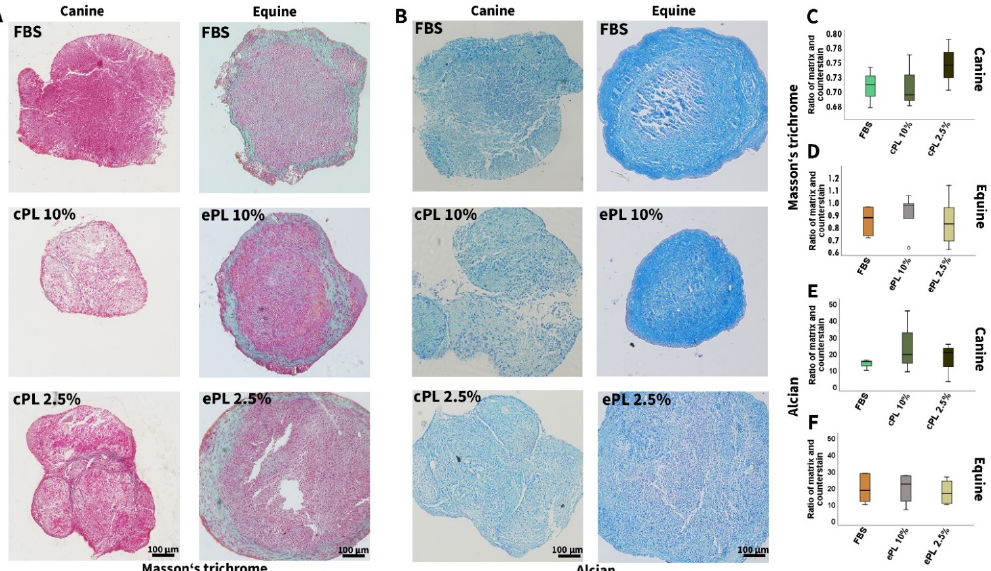
Figure 6. Chondrogenic differentiation. Representative bright-field photomicrographs show canine (left column) and equine (right column) mesenchymal stromal cells (MSC) after chondrogenic differentiation and Masson’s trichrome ( A ) and Alcian ( B ) staining. Boxplots display the corresponding data obtained by image analysis using Fiji ImageJ ( C – F ). MSC were cultured in the media indicated before differentiation was induced (FBS: fetal bovine serum; cPL: canine platelet lysate; ePL: equine platelet lysate). Data were obtained using MSC from the same n = 5 donor dogs or horses in each group.